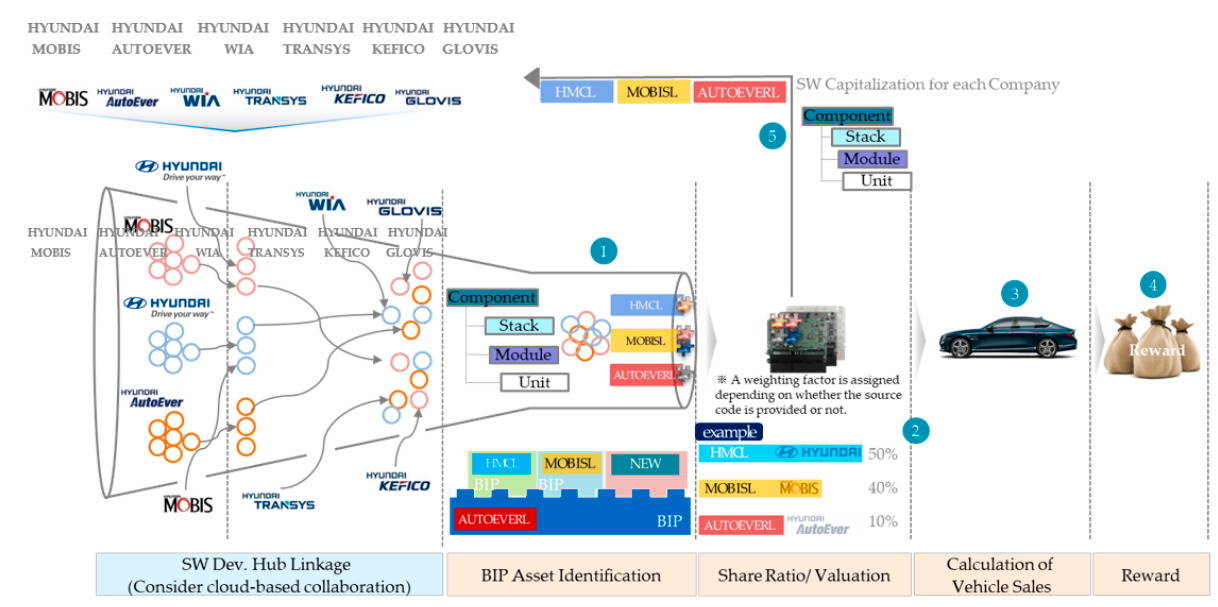
Figure 13. Example of revenue sharing concept.